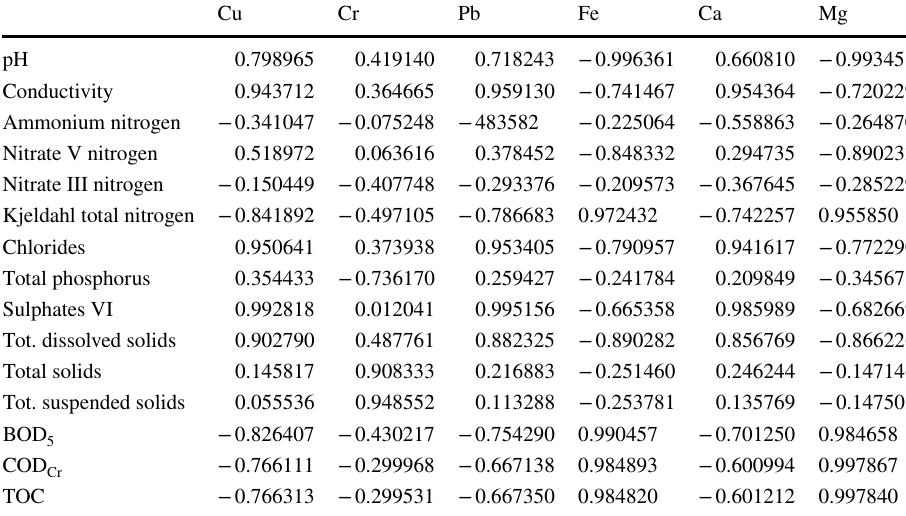
Table 4 Averaged linear correlation